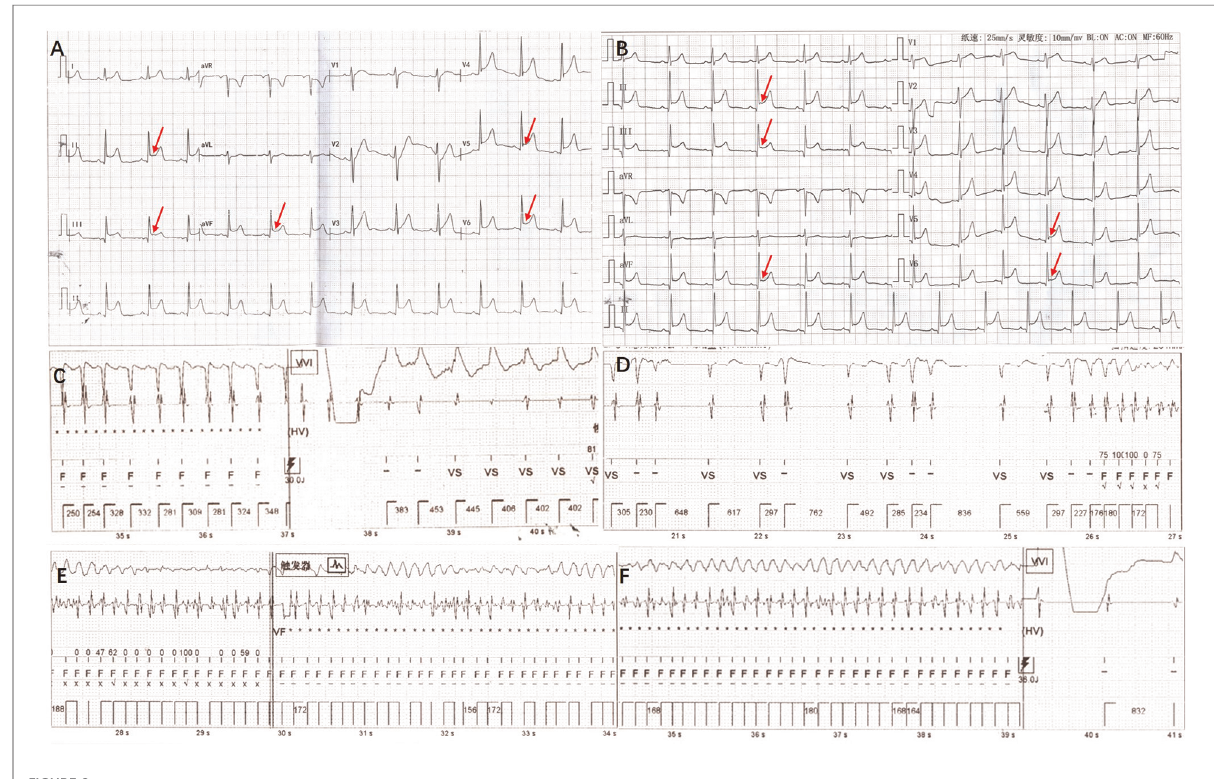
FIGURE 2 ECG and point diagram of ICD cavity for this patient. ( A ) ERP could be detected on ECG: elevation of J-point in inferior leads (II, III, AVF) and lateral leads (V5, V6). ( B ) J wave amplitudes were decreased slightly after administration of oral quinidine. ( C ) Diagram of ICD cavity shows atrial arrhythmias with electrical shock and ventricular pacing administered by ICD. ( D – F ) Diagram of ICD cavity shows VF occurred and was terminated by electrical shock of